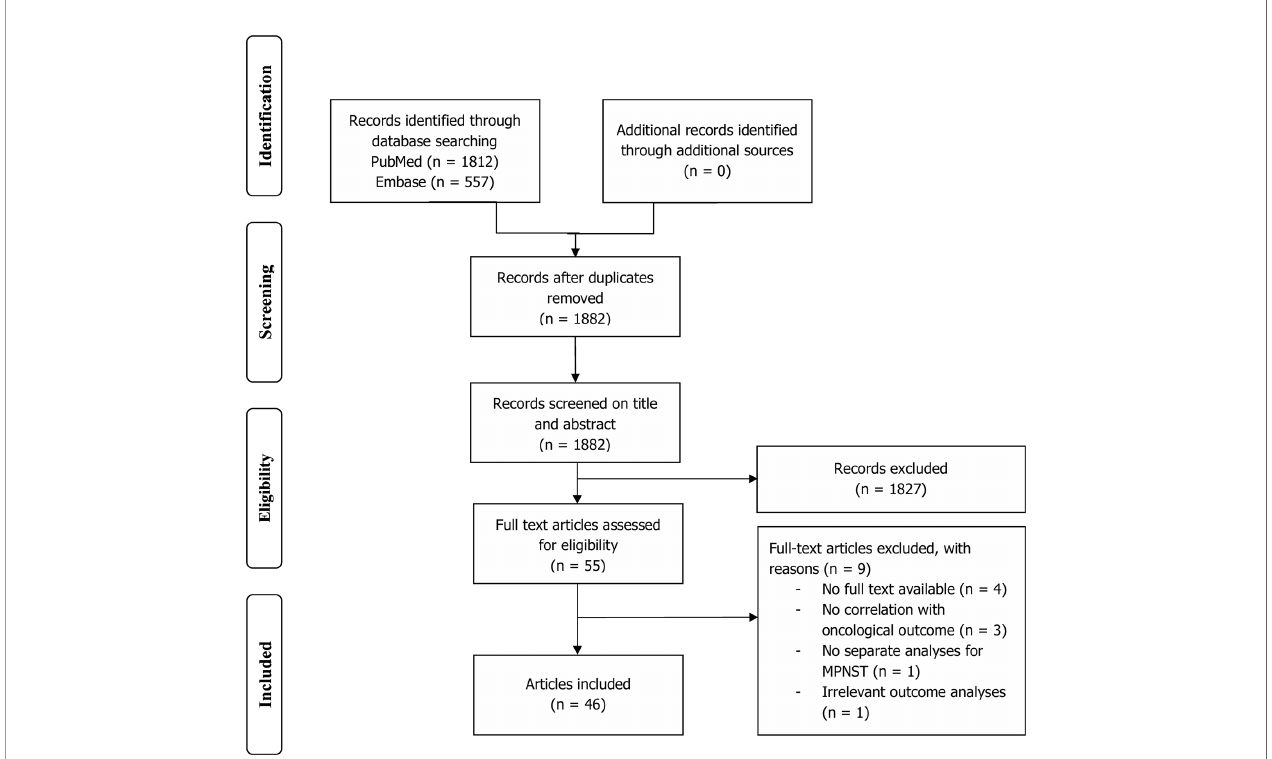
FIGURE 1 | Flowchart depicting study